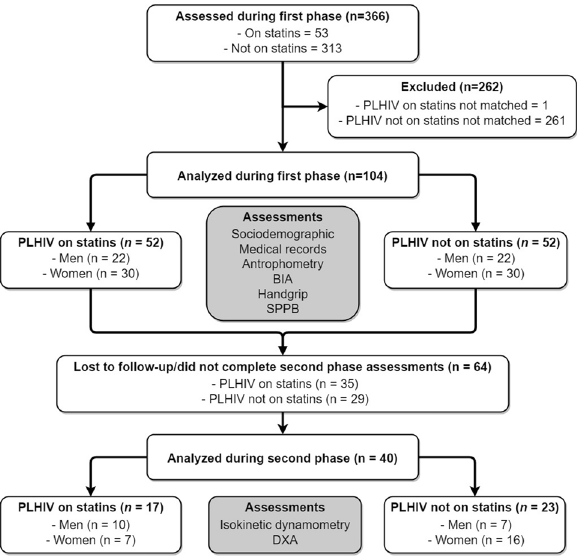
Figure 1. The flow chart of the study’s participants. PLWH people living with HIV, BIA bioelectric impedance analysis. In total, 366 participants were evaluated, 53 PLWH were identified using statins and were paired according to age, sex, body mass index and race with PLWH not using statins. Finally, 104 participants (52 per group) were included in the clinical determination of sarcopenia. Finally, 40 PLWH completed the DXA and isokinetic dynamometry evaluation. DXA dual-energy X-ray absorptiometry, SPPB short physical performance